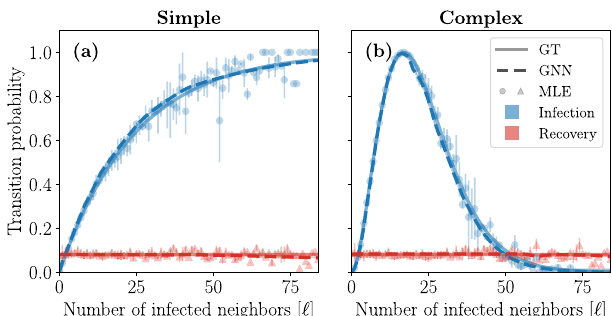
Fig. 1 Predictions of GNN trained on a Barabási-Albert random network 72 (BA). a Transition probabilities of the simple contagion dynamics. b Transition probabilities of the complex contagion dynamics. The solid and dashed lines correspond to the transition probabilities of the dynamics used to generate the training data (labeled GT for "ground truth''), and predicted by the GNN, respectively. Symbols correspond to the maximum likelihood estimation (MLE) of the transition probabilities computed from the dataset D . The colors indicate the type of transition: infection ( S → I ) in blue and recovery ( I → S ) in red. The standard deviations, as a result of averaging the outcomes given ℓ , are shown using a colored area around the lines (typically narrower than the width of the lines) and using vertical bars for the